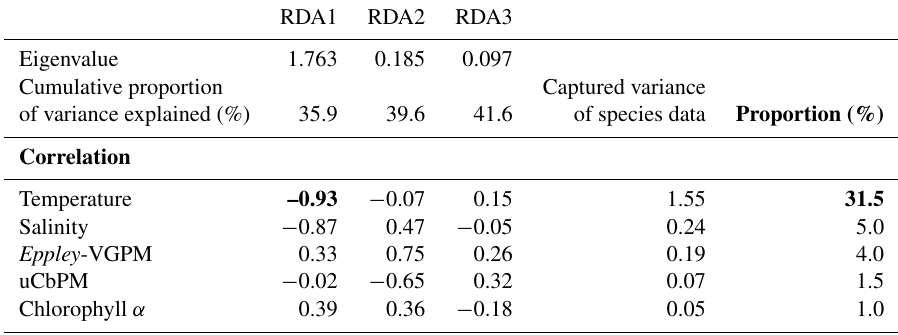
Chlorophyll α 0.39